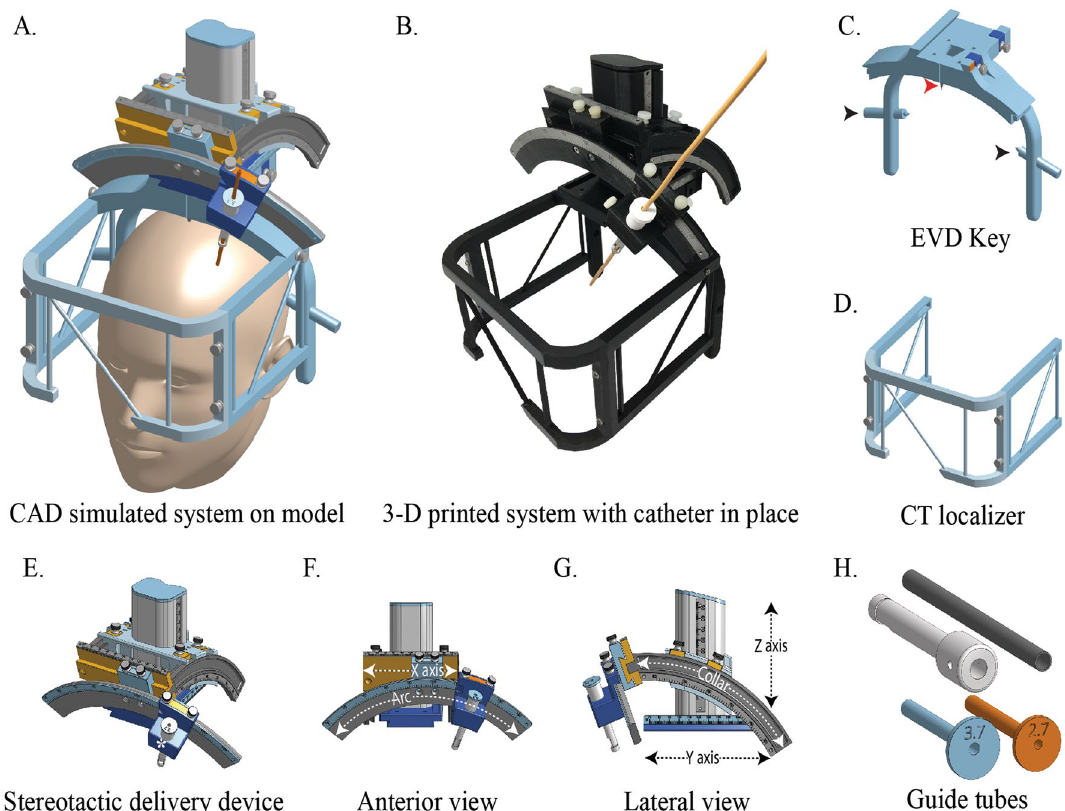
Figure 1. Stereotactic system for external ventricular drainage (EVD) catheter placement. ( A ) CAD model of the complete system mounted on a head with the EVD catheter in place (dark orange); ( B ) 3D printed system with EVD catheter in situ; ( C ) skull-mounting device- the EVD key with 4 fixation points -two side screws labeled with black arrowheads, a midline anterior pin labeled with a red arrowhead and a midline posterior pin (not seen); ( D ) compact N Bar CT localizer. ( E–G ) Stereotactic targeting device with 3 linear degrees of freedom along, X, Y and Z direction and two angular degrees of freedom- arc and collar angles, respectively. The arc carrier (labeled with a white asterisk in E) serves as the platform for mounting and un-mounting the guide tubes. ( H ) Outer guide tube (grey), drill guide (black) and reducing tubes for different catheter sizes (blue and